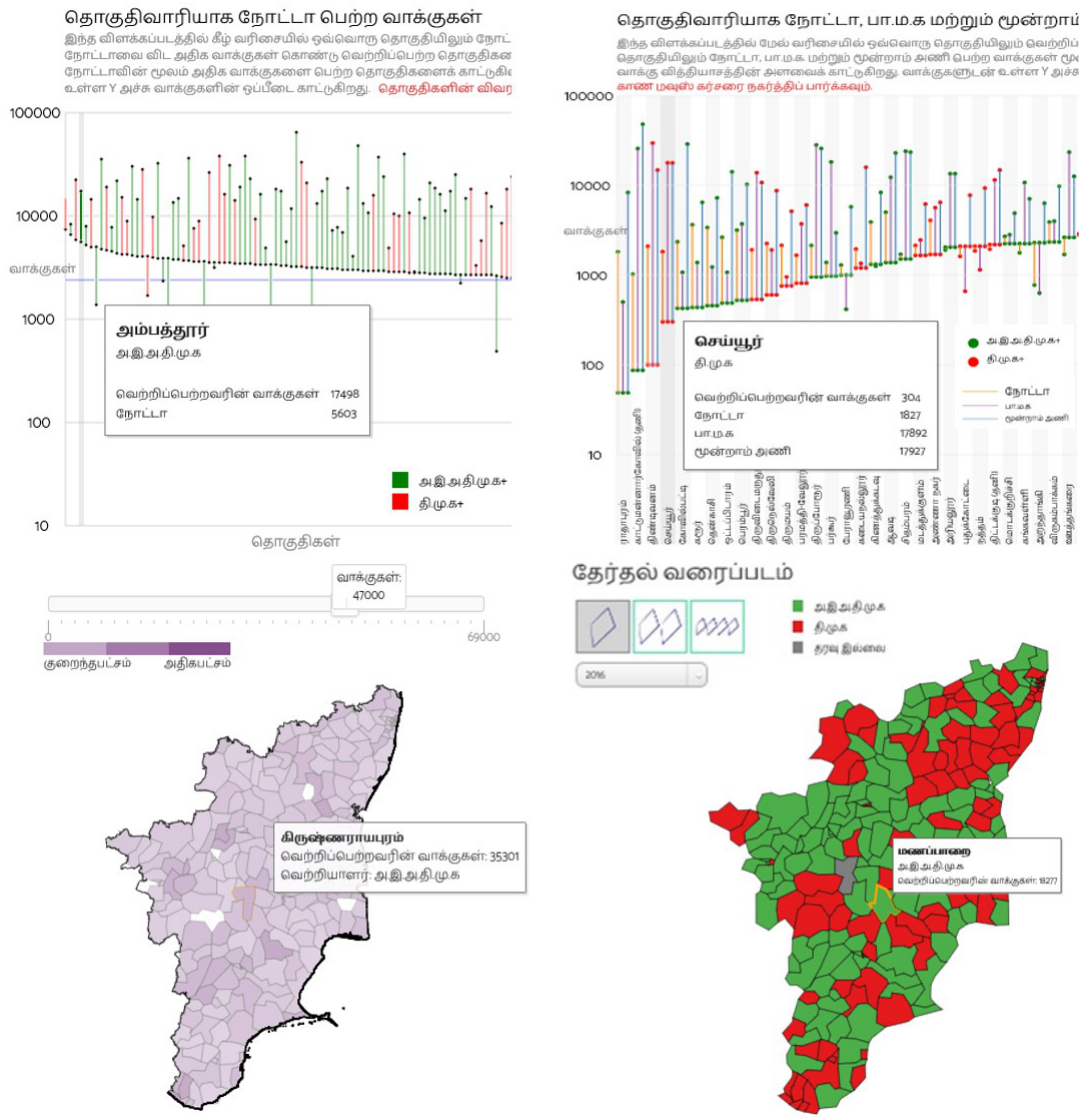
Figure 18: Tamil Nadu Assembly Election Analysis in Tamil